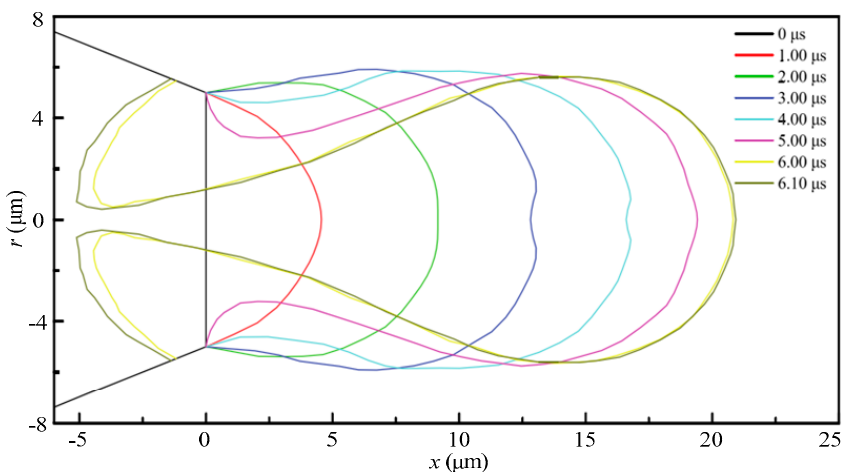
Figure 5. The modeling of the droplet formation process in one cycle.